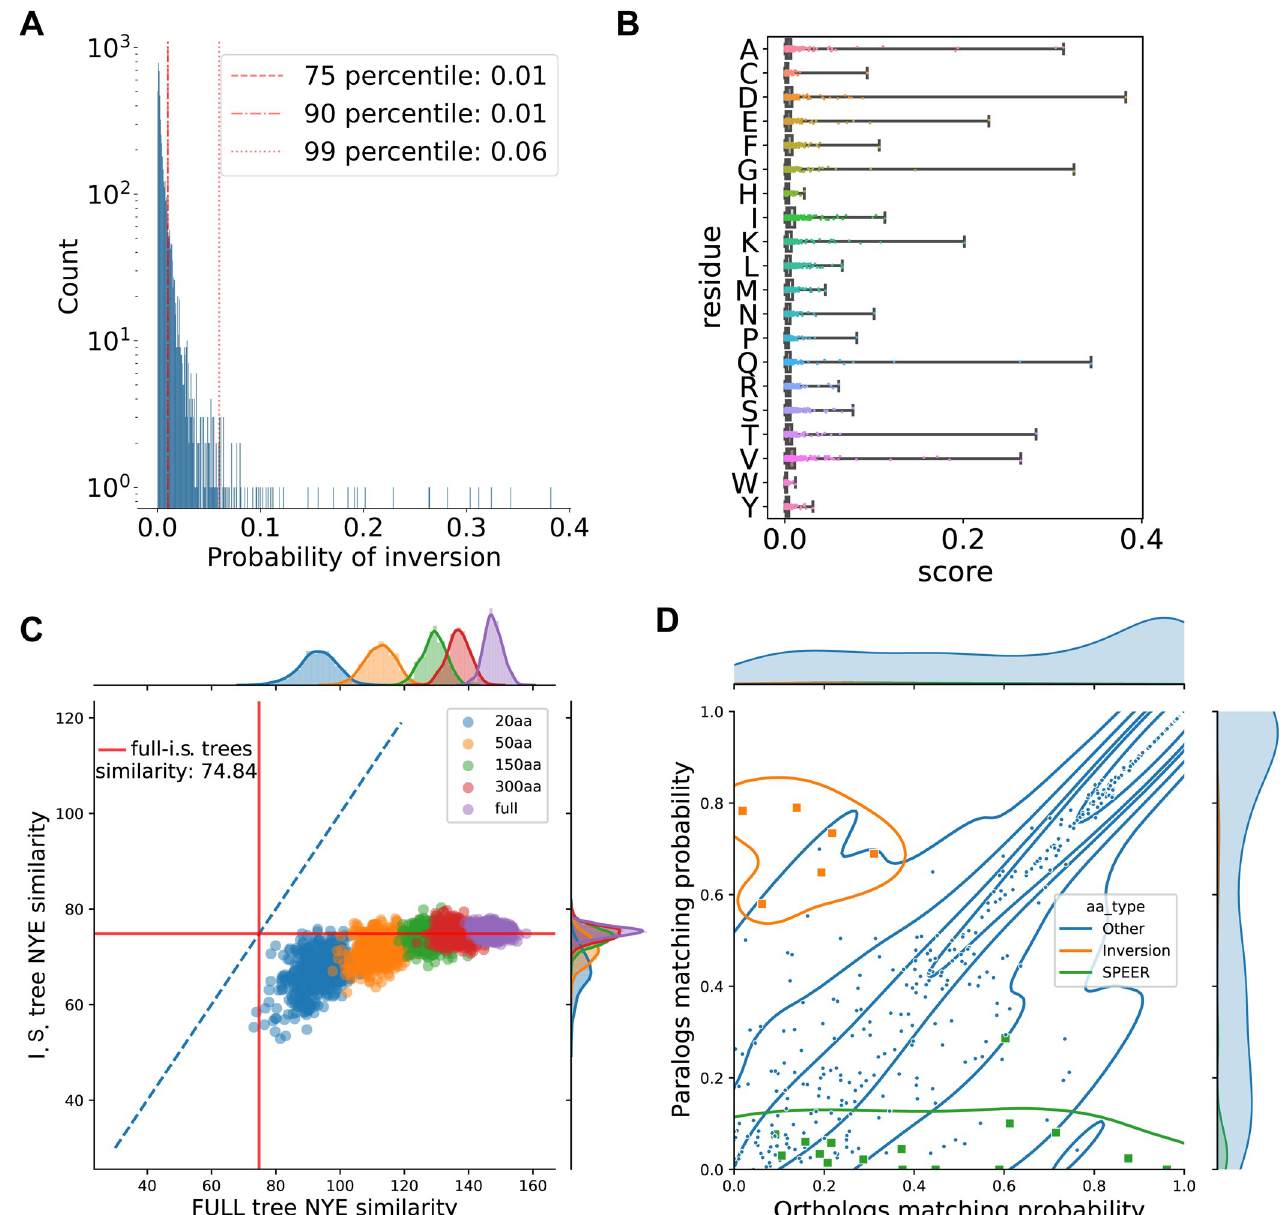
Fig 4. Outcome to the validations. (A) Distribution of the simulated evolution DIRphy scores. A 5000 random amino acid sequence was evolved through the fish EGFR phylogenetic tree using the same evolutionary models used to generate the tree. The resulting MSA was used to compute the DIRphy score. (B) Distribution per amino acid of the simulated evolution DIRphy scores as shown by the reference ( S . anshuiensis EGFRa). (C) Bootstrap trees similarity to the full and inverted sites trees. The color represents the length of the sub-alignment used to generate the bootstrap tree. The red line shows the similarity between the full and inverted sites trees. The blue line is the identity line. (D) Comparison of the sites identified by DIRphy and SPEER. The matching probability of the HMM of four sub-alignments was used to compare between species the orthologs (EGFRa vs EGFRa, EGFRb vs EGFRb) and paralogs (EGFRa vs EGFRb). The matching probability is calculated as the average of two dot products of the frequency arrays. The orange color shows sites where an inversion was identified, while the green color shows sites where the p-value of SPEER score is lower than 0.01.